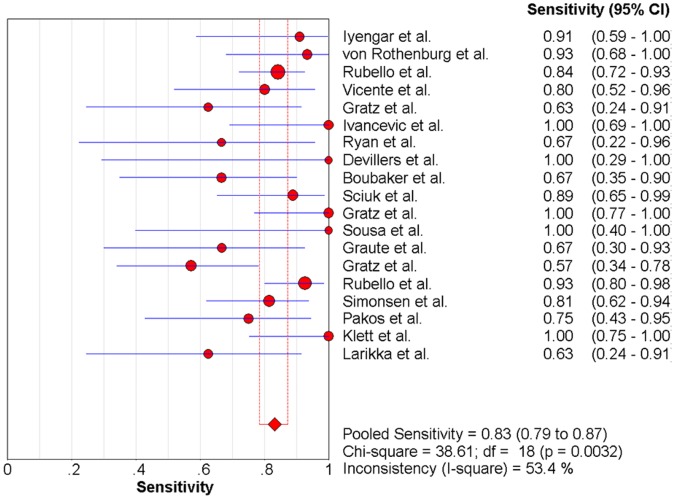
Forest plot for the sensitivity of anti-granulocyte scintigraphy with 99mTc-monoclonal antibodies to diagnose periprosthetic joint infections (PJI).Sensitivity  =  0.83 (95% CI, 0.79-0.87).